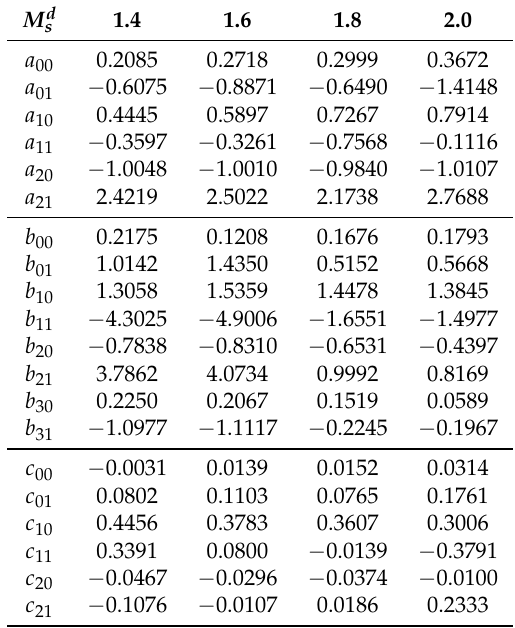
Table 2. Coefficient parameters in Equations (26)–(35) in regulator design.